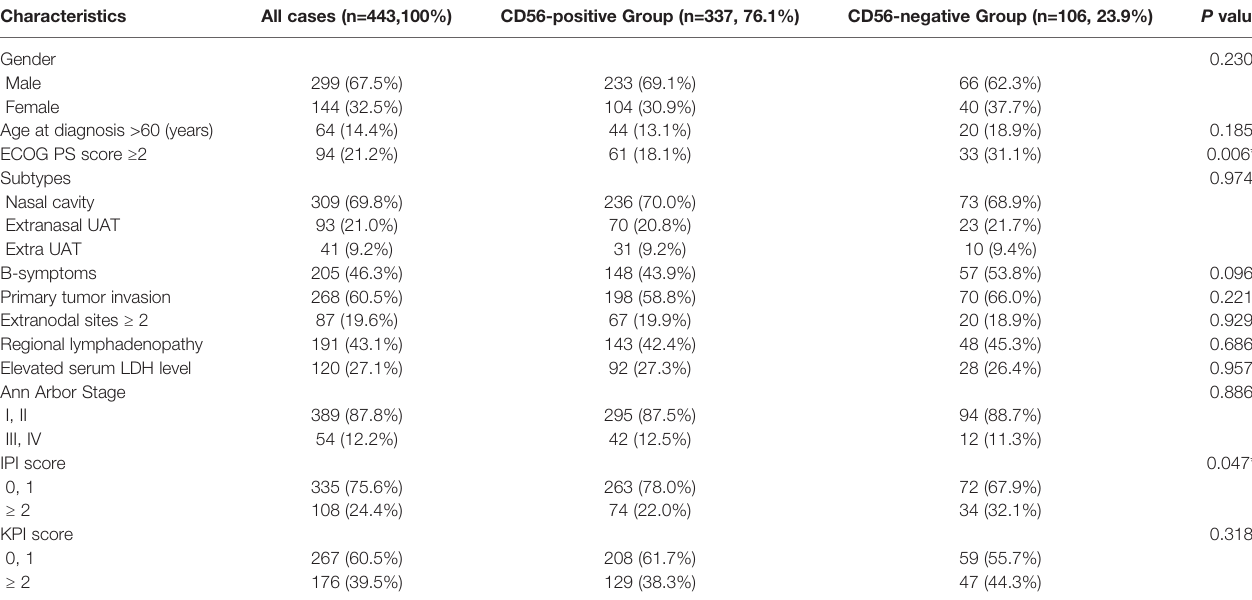
TABLE 1 | Clinical characteristics and CD56 expression status of 443 patients at diagnosis with NKTCL.